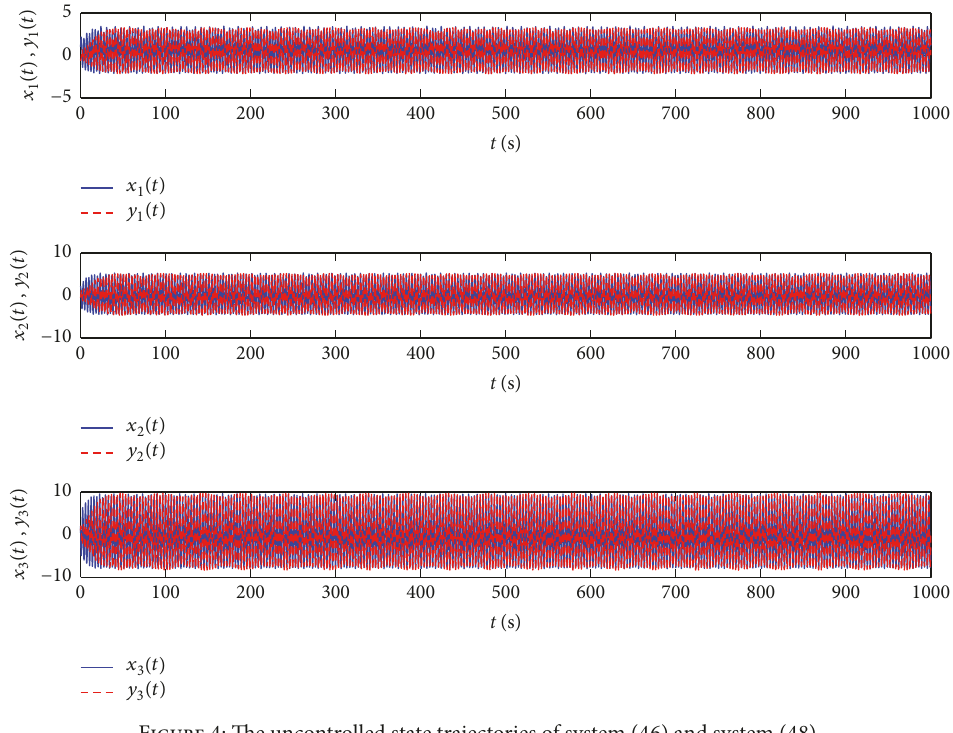
Figure 4: The uncontrolled state trajectories of system (46) and system (48).